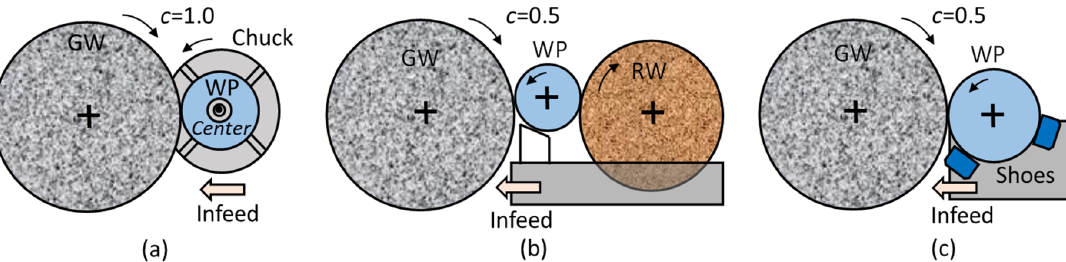
Figure 4. Cylindrical grinding methods (WP: workpiece, GW: grinding wheel, RW: regulating wheel). ( a ) Center-chuck type grinding c = 1.0; ( b ) Centerless grinding c = 0.5; ( c ) Shoe centerless grinding c = 0.5.